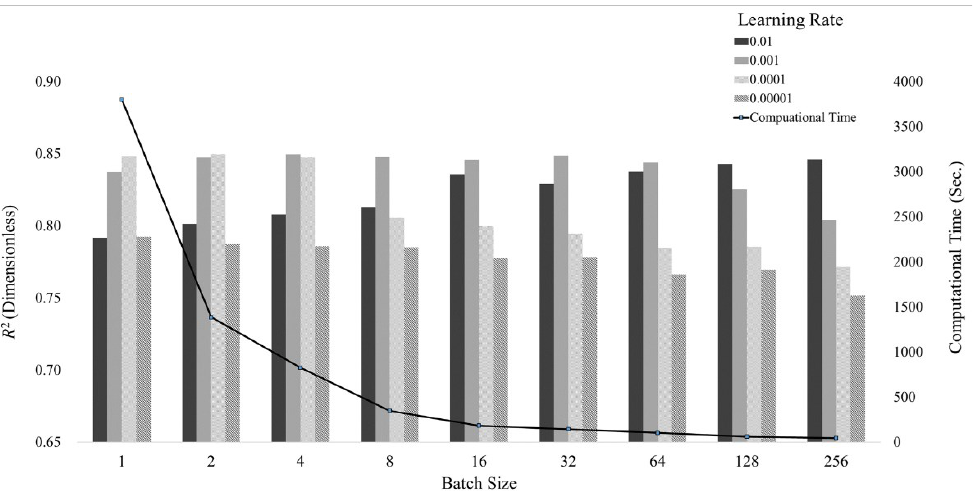
Figure 9. Sensitivity analysis results on the learning rate and batch size for the LSTM model.